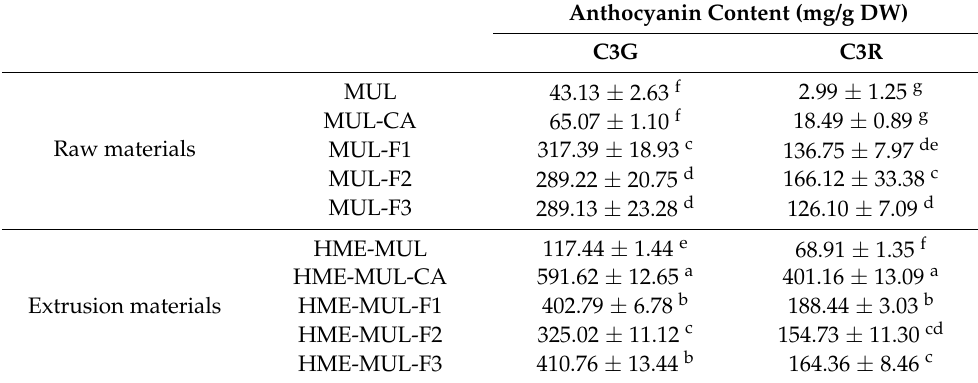
Table 3. Anthocyanin contents of mulberry extract